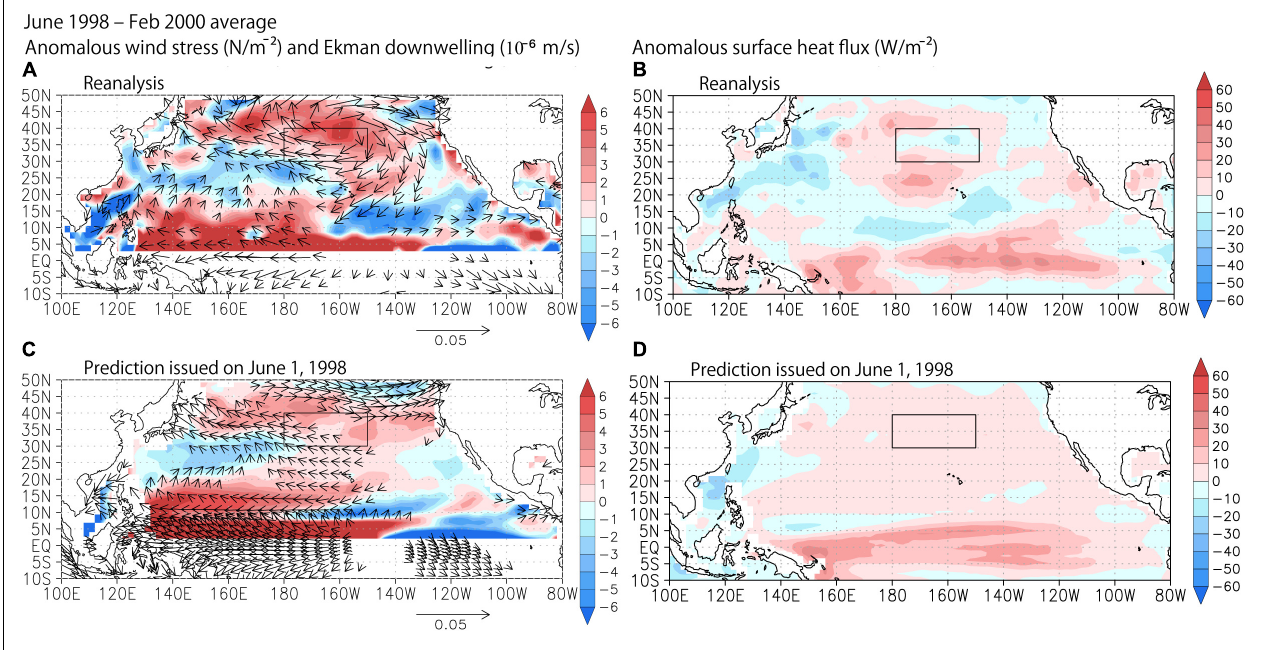
FIGURE 5 | (A) Anomalous surface wind stress (vector: N m − 2 ) and its induced-Ekman vertical velocity (shaded: 10 − 6 m s − 1 ) averaged in June 1998–February 2000 based on the reanalysis data. Positive values show downwelling. The rectangle box demarcates the region of 30 ◦ –40 ◦ N, 180 ◦ –150 ◦ W. (B) Same as (A) , but for surface heat flux (W m − 2 ). Positive values show that it warms ocean. (C,D) Same as (A,B) , but for prediction issued on June 1, 1998 (ensemble